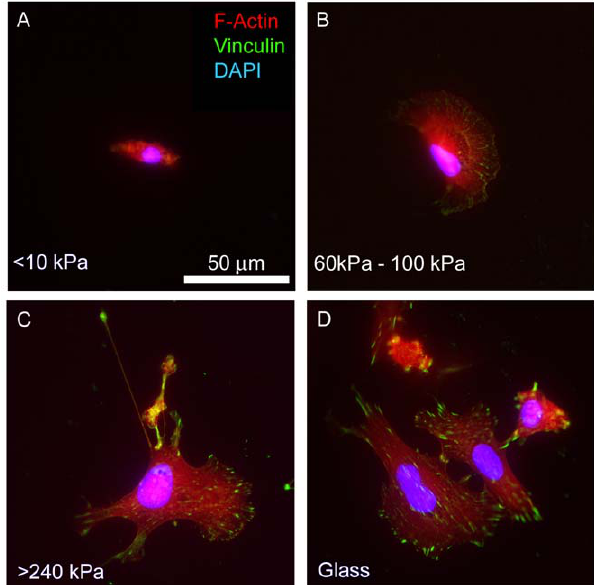
Figure 6. Cytoskeletal organization changes as hydrogel rigidity is altered. Representative fluorescent images of NIH3T3 cells stained for F-actin (red), focal adhesion protein vinculin (green), and nuclear DNA (blue, although appears slightly purple due to the actin colocalization). Panels A–C show cell patterns obtained on different stiffness regions on the same hydrogel. Panel D shows cells on glass coated with fibronectin.